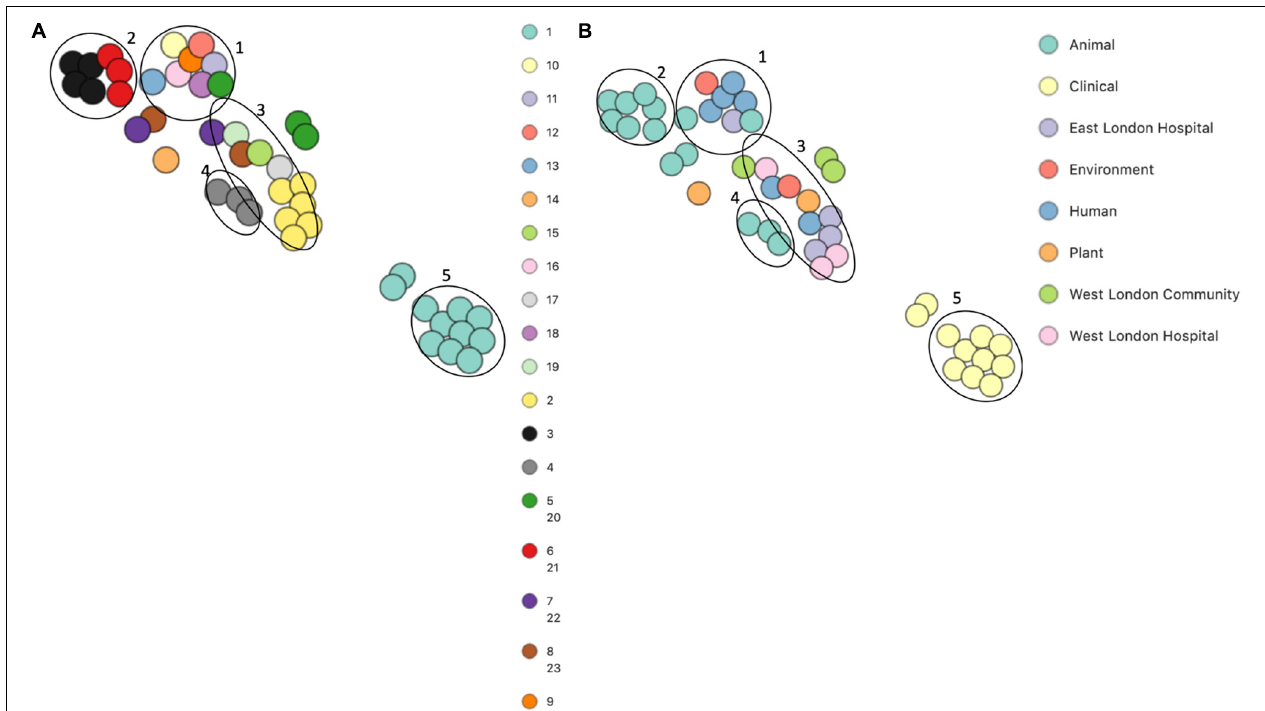
FIGURE 6 | PoPpunk t-SNE analyses of the distance of the accessory genome in 45 S. hominis isolates. Analyses were performed using PopPUNK pipeline. The maximum number of mixture components was set at 5 and for the perplexity of t-SNE set at 15. (A) Combined core and accessory genome cluster from PopPUNK analyses: (B) isolation